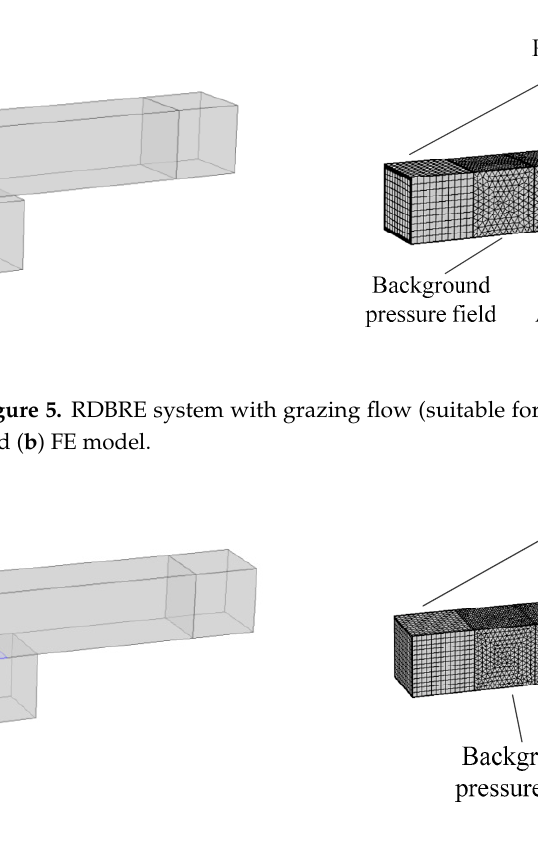
Figure 4. Schematic view of the basic resonance element.